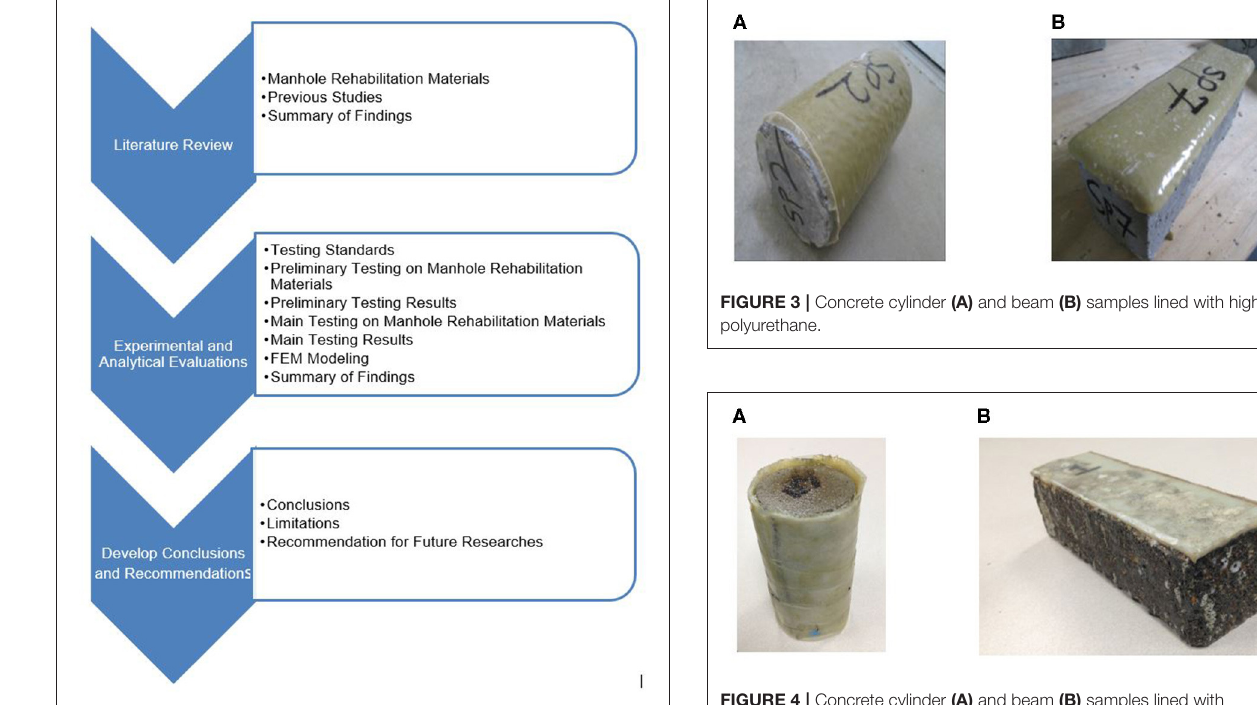
FIGURE 1 | Research methodology flowchart.